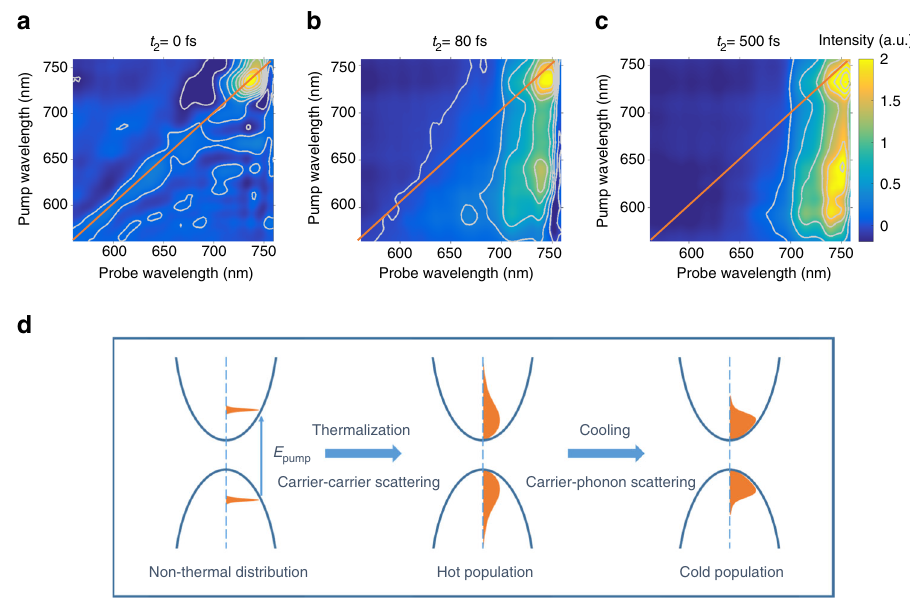
Fig. 2 Carrier relaxation probed with 2D electronic spectroscopy. a – c 2DES maps for time delays t 2 of a 0 fs, b 80 fs and c 500 fs for an excitation density of 2 × 10 18 cm − 3 . The diagonal of the 2DES maps is indicated with orange lines. d Schematic illustration of carrier relaxation processes. Initially, a non-thermal carrier energy distribution is excited. After undergoing carrier-carrier scattering, carriers form a thermalized distribution with a temperature higher than the lattice. Through carrier-phonon scattering, the carriers subsequently cool down until they reach an equilibrium with the lattice